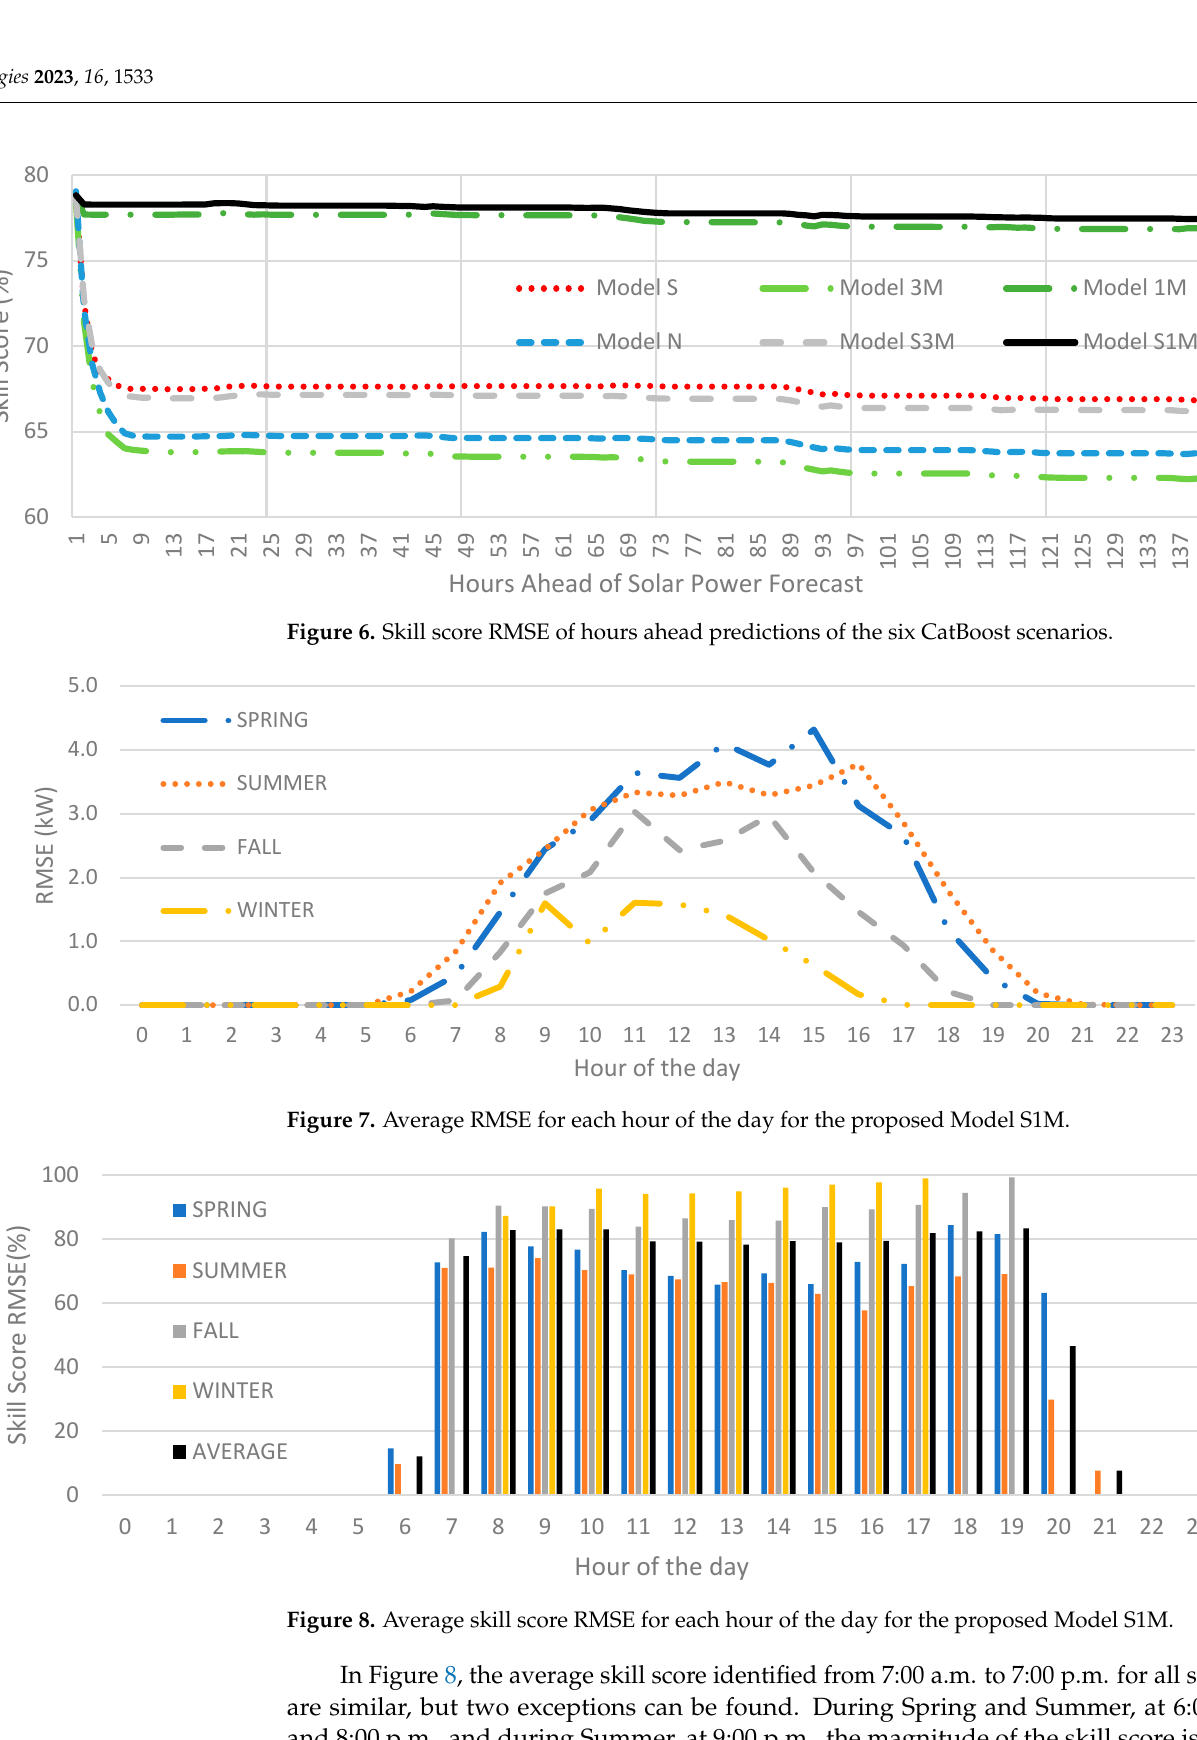
Figure 7. Average RMSE for each hour of the day for the proposed Model S1M.